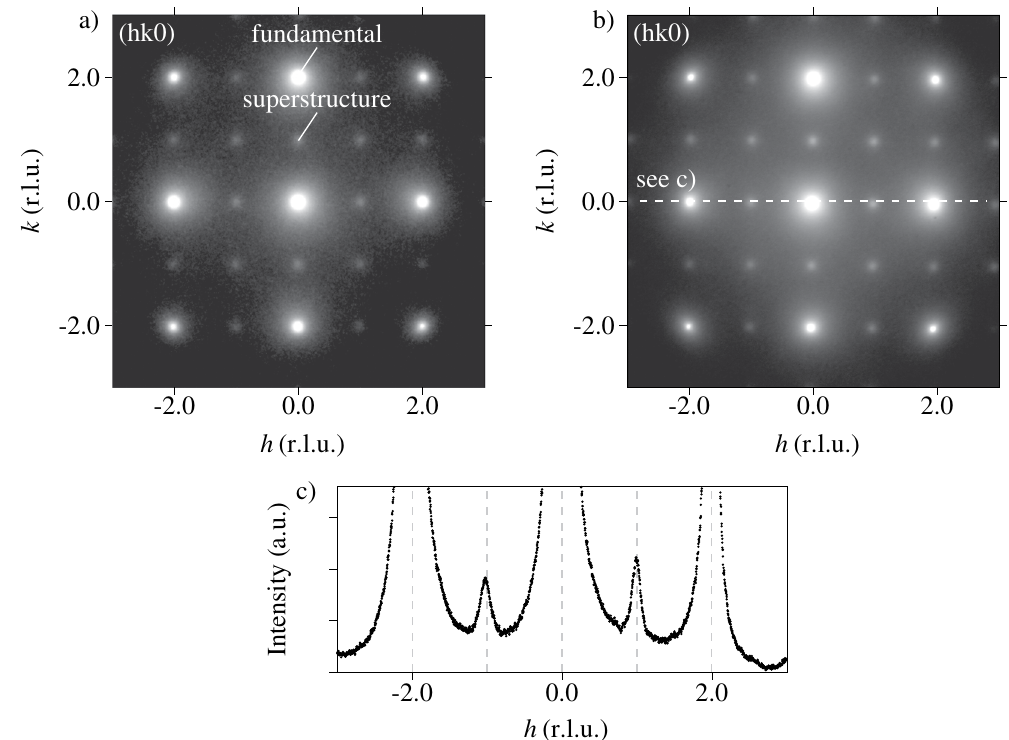
Figure 2. Electron diffraction image along the [001] direction of the Al-Cu-Li alloy in ( a ) naturally aged and ( b ) naturally aged plus 5 minutes at 433 K artificially aged condition. L1 2 superstructure reflections are clearly visible in both aging conditions. ( c ) depicts a line intensity profile as indicated in ( b